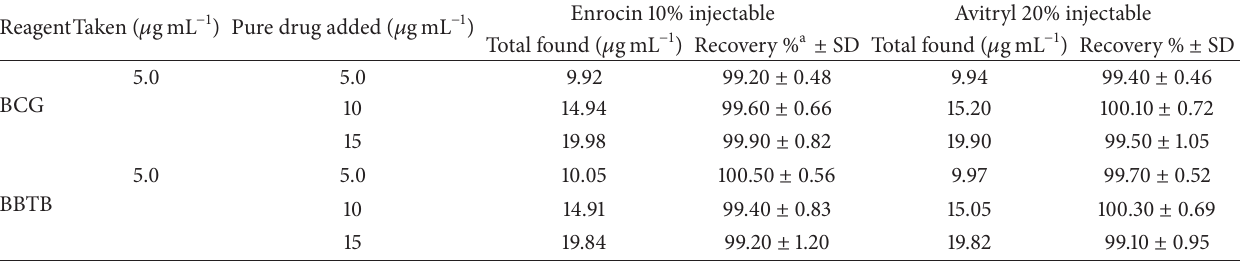
Table 7: Determination of ENF in its pharmaceutical dosage forms applying the standard addition technique.